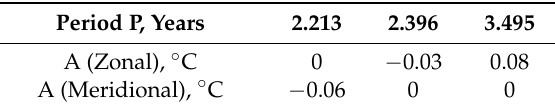
Table 7. A simulation for tidal component cosine amplitudes (in ◦ C) over the period 1959.5 to 2016.5. The amplitude A entries are in ◦ C for each component, and are given for each period P by Acos(2 π [t − 2039.96]/P) with t in decimal